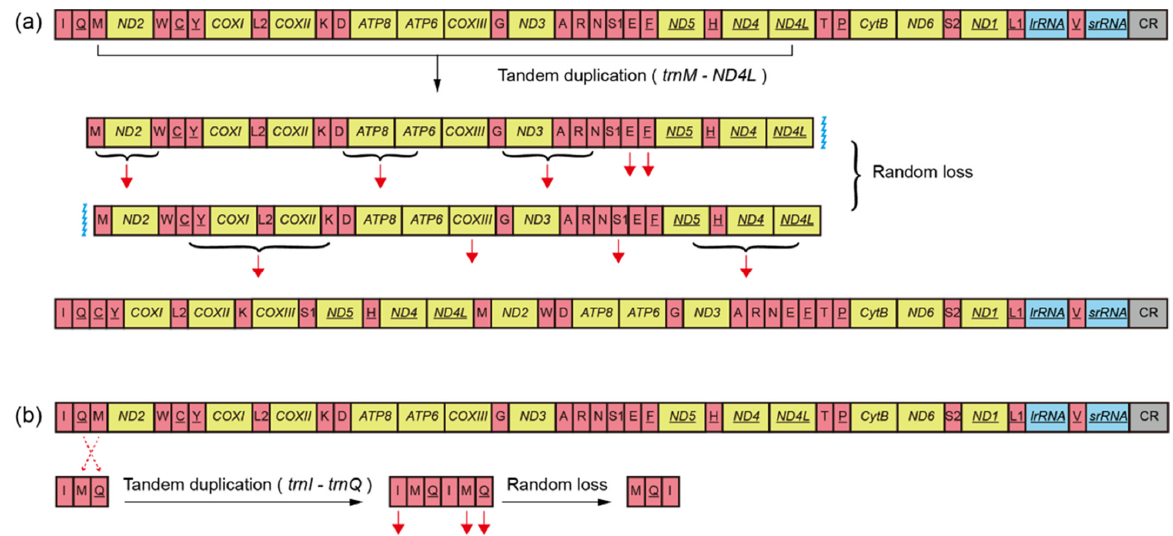
Figure 6. The mechanism proposed for gene rearrangement in Potamyia and Arctopsyche by tandem duplication and random loss model. The colors of the gene and control region are the same as in Figure 5. The black arrow indicates gene tandem-duplication. The red dotted arrow indicates the absence of a gene. ( a ) the genus Potamyia ; ( b ) the genus Arctopsyche .